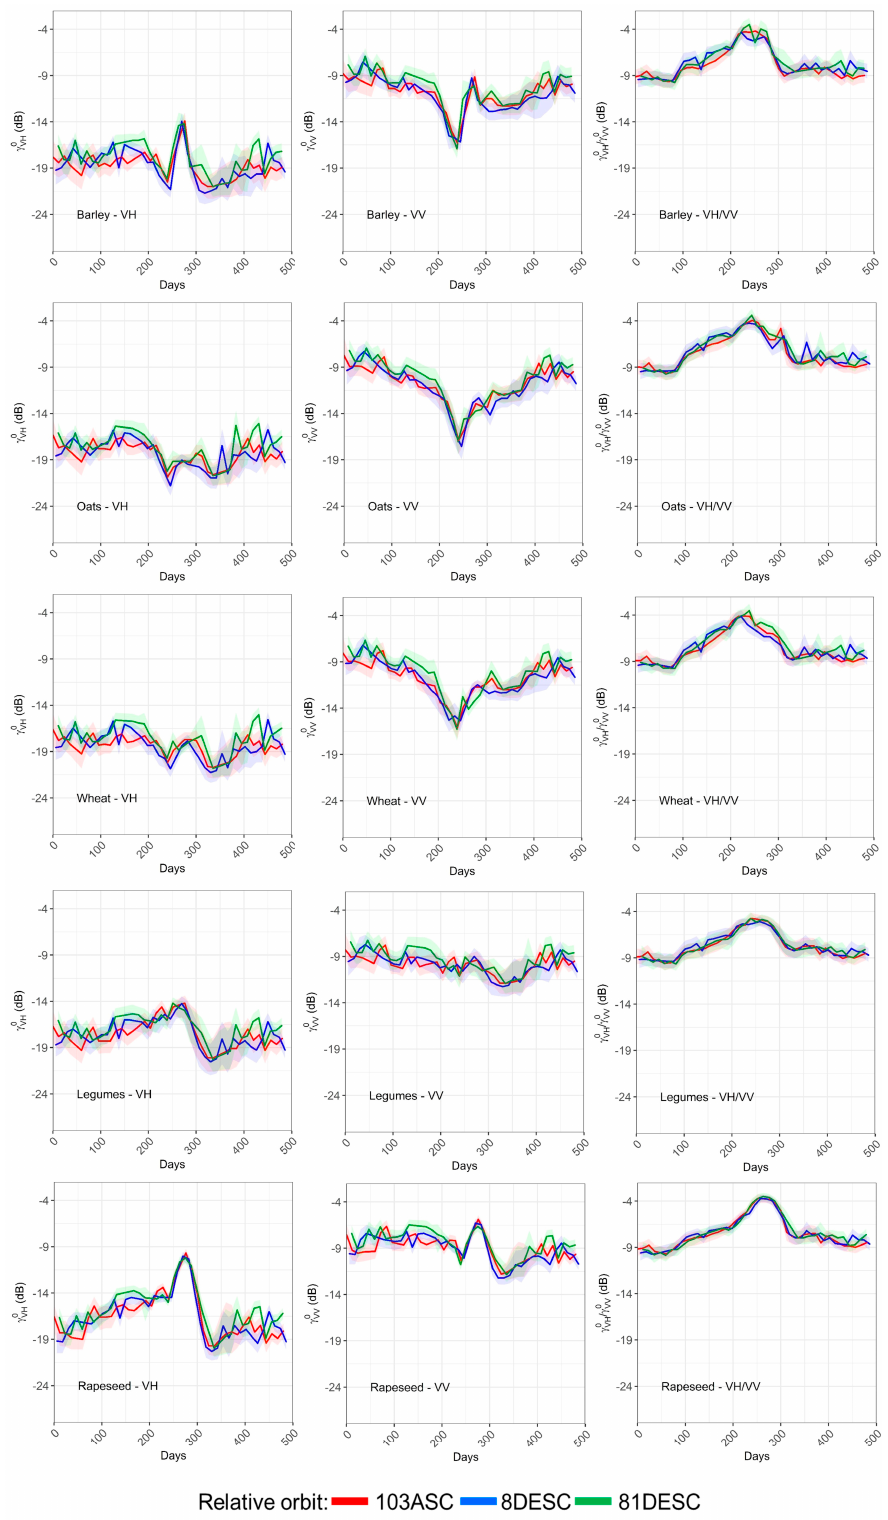
Figure 6. Median temporal signatures of the main winter crops (barley, oats, wheat, legumes and rapeseed) for VH, VV and VH/VV. The three relative orbits are represented in different colors (see the legend). The interquartile range is represented for all the different time series as a colored shadow. The horizontal axes represent the period of study, from 1 September 2015 (day 0) to 30 December 2016 (day